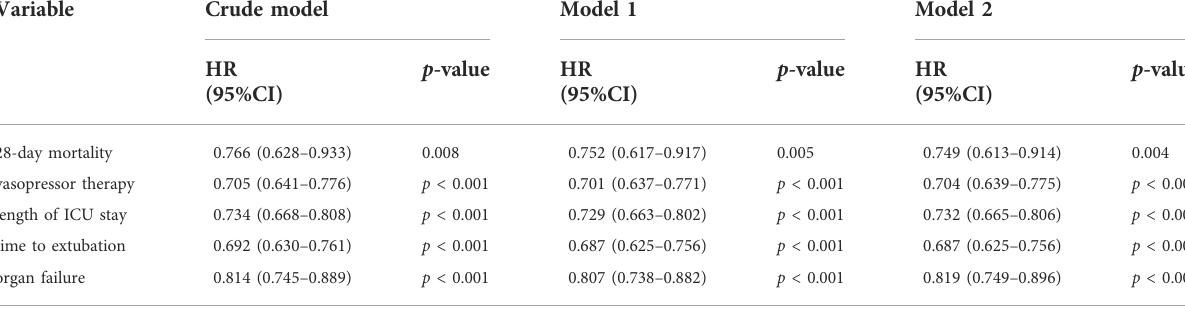
TABLE 2 Effects of SFI in septic shock patients receiving MV in different models.